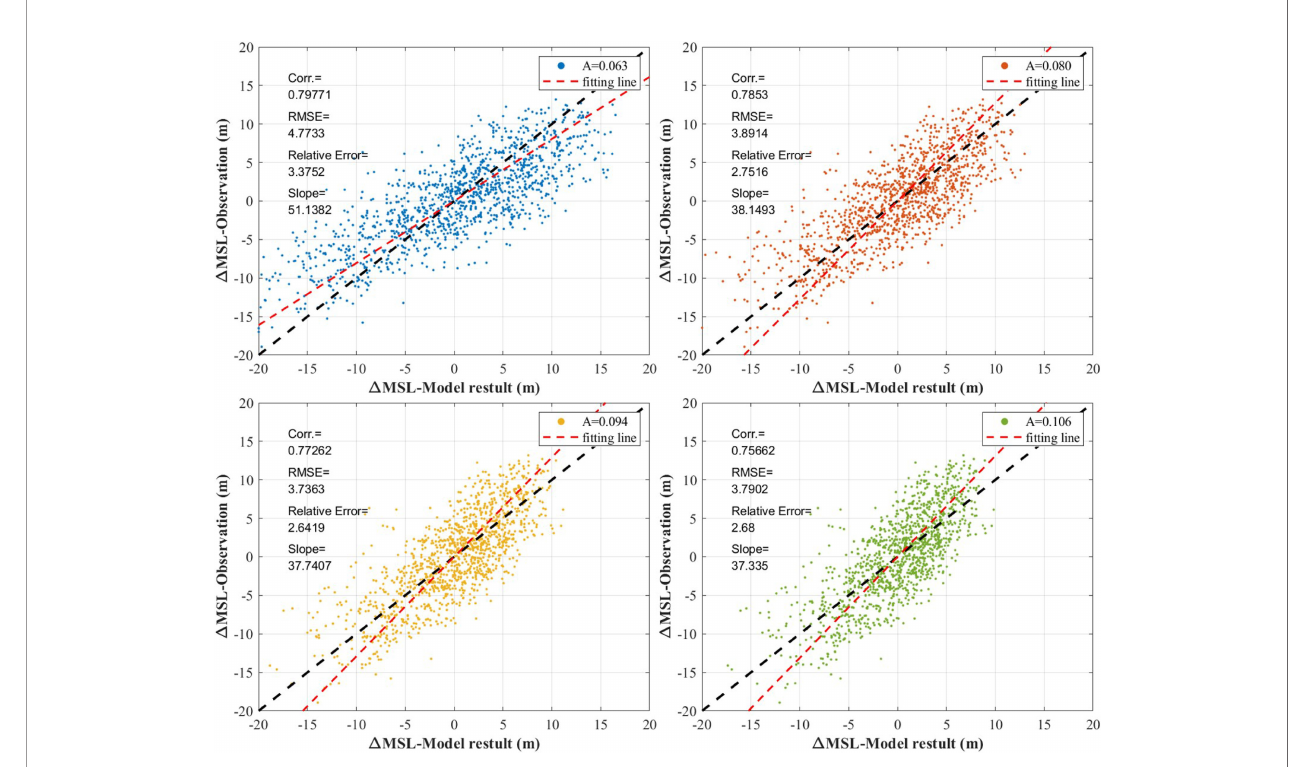
FIGURE 9 | Concordance analysis for 4 different values of A